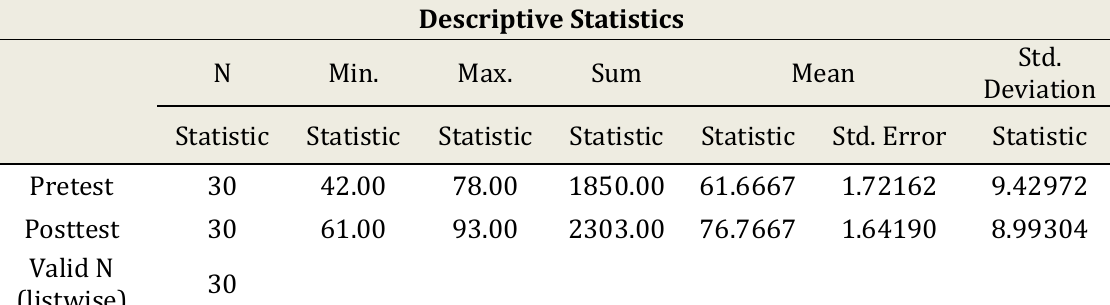
Table 6. The mean score and standard deviation of students’ pre -test and post-test in experimental